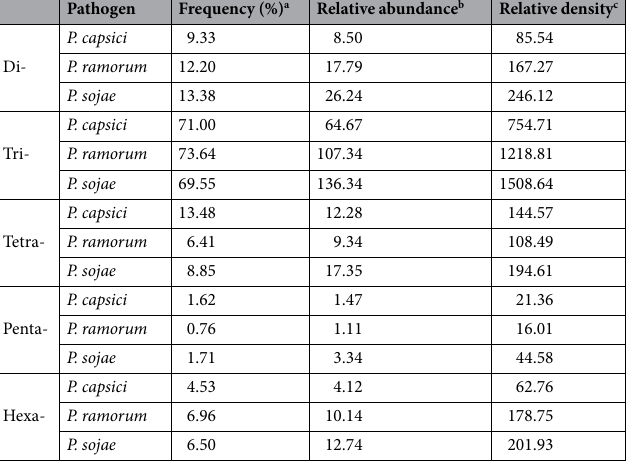
Table 2. Frequency, relative abundance, and relative density of each motif length in P. capsici , P. ramorum , and P. sojae transcriptomes. a Frequency was calculated for each organism by dividing the total number of each motif length by the total number of microsatellites count. b Relative abundance is defined as number of microsatellites of each motif length per Mb of analyzed sequence. c Relative density is defined as the total length of microsatellites (bp) per Mb of analyzed